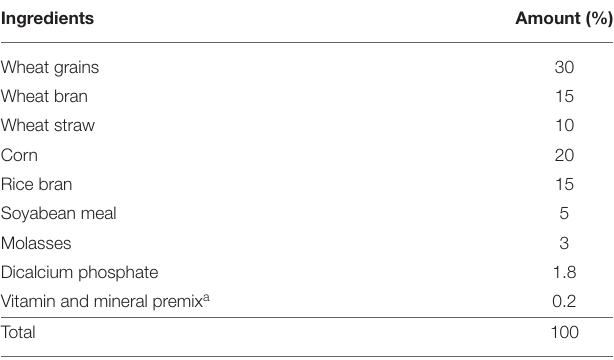
TABLE 1 | Basal diet formulation (% DM).